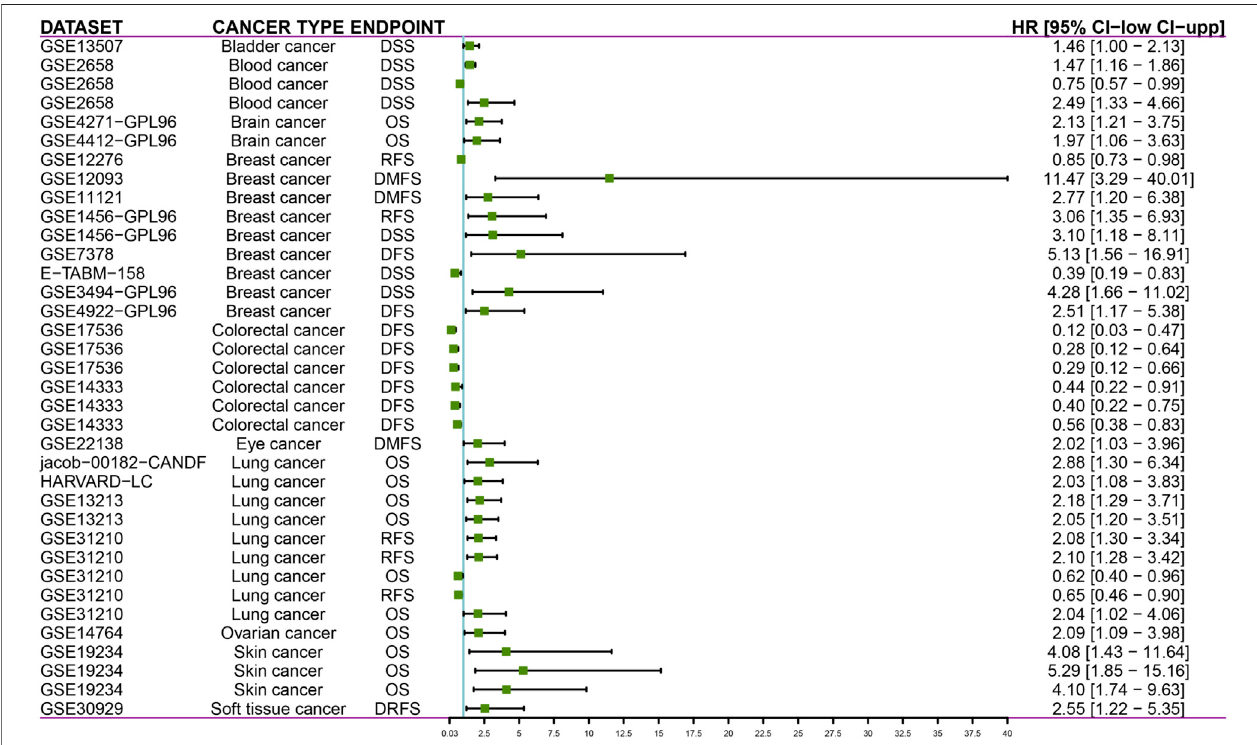
FIGURE13| PrognoScandatabasessuggestthatincreasedDTYMKexpressioncorrelateswithdifferentoutcomesincancers.DSS,diseasespeci fi csurvival;OS, overall survival; RFS, relapse free survival; DFS, disease free survival; DMFS, distant metastasis free survival; DRFS, distant recurrence free